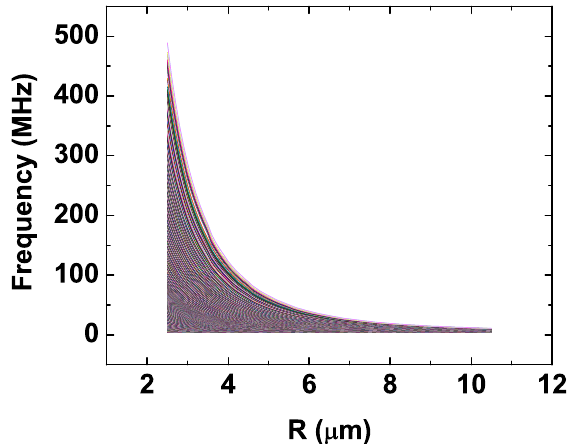
Figure 3. The repulsive energy levels calculated for the hexagon configuration shown in Figure